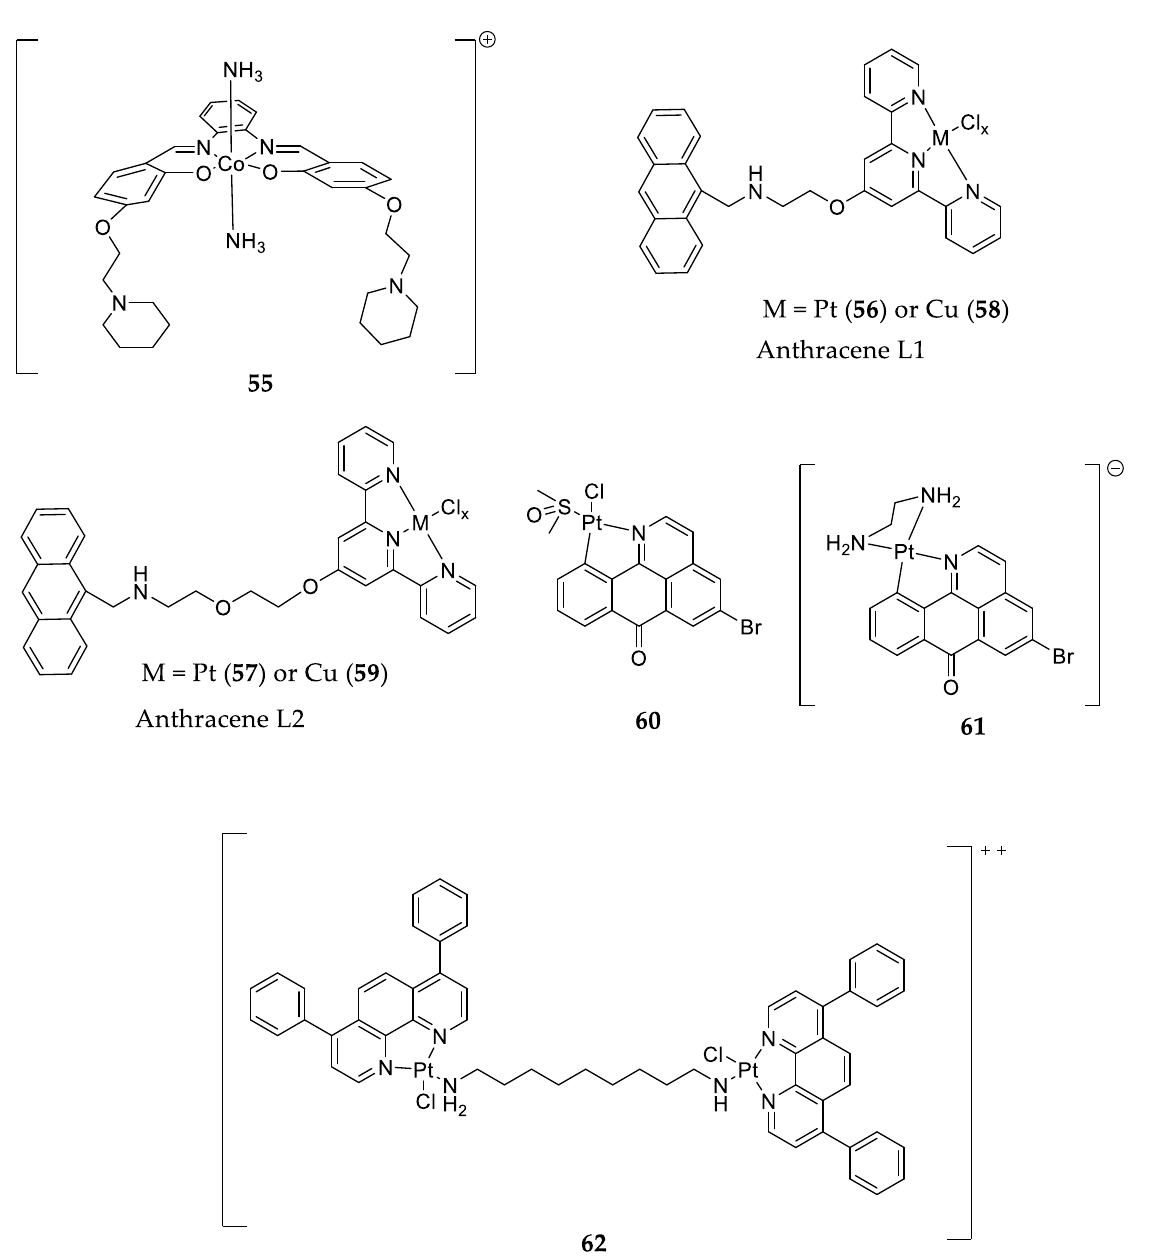
Figure 14. Structure of metal complexes able to bind to and stabilize c-MYC G4.